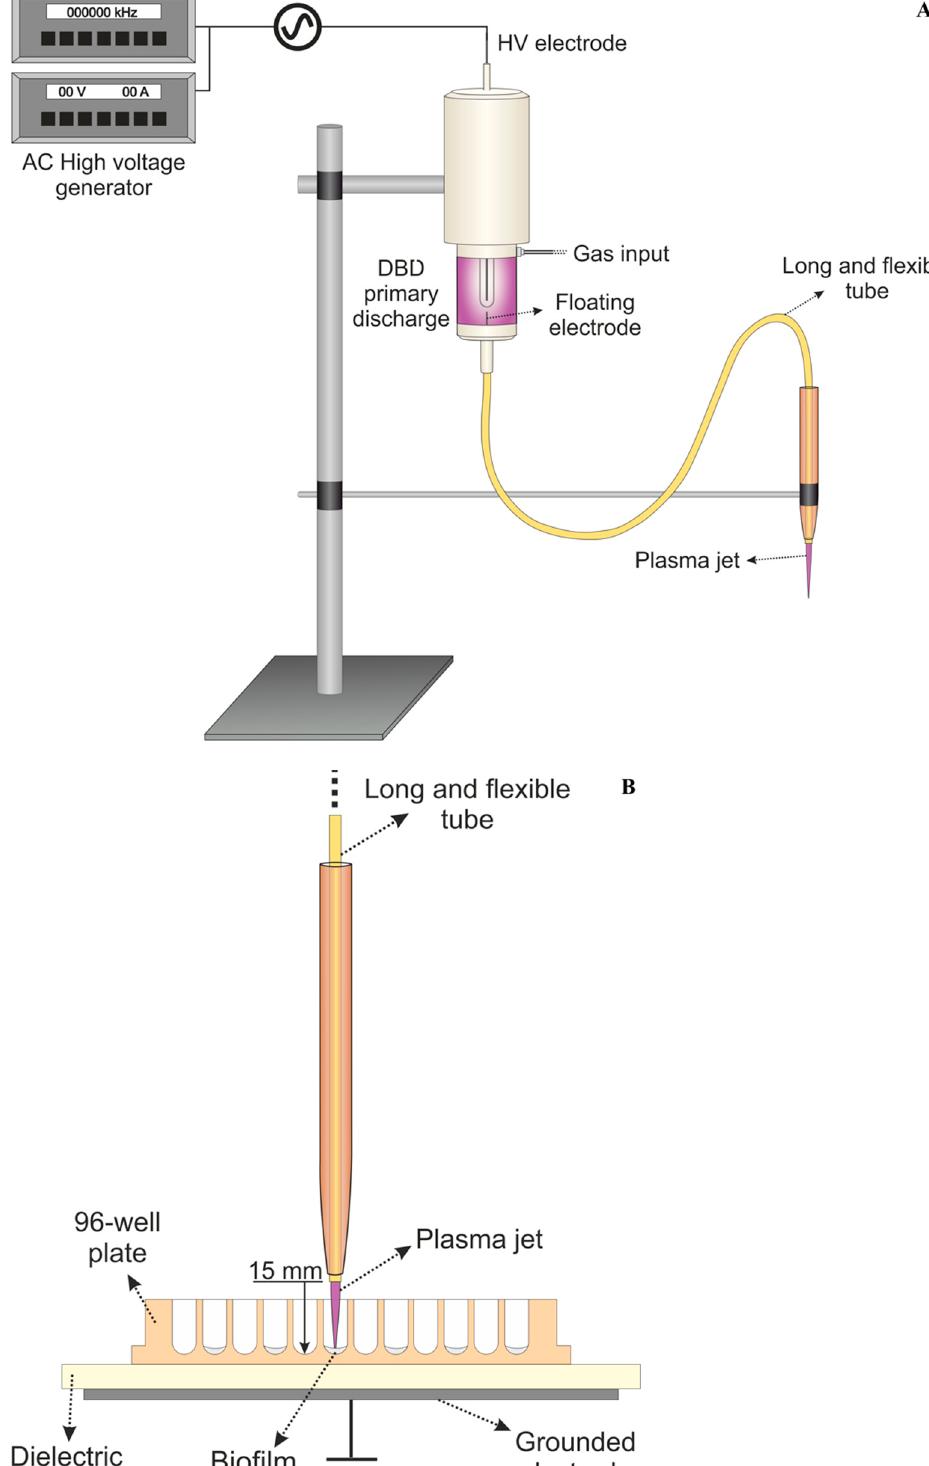
Figure 1. ( A ) Schematic setup of the plasma jet with flexible plastic long tube. ( B ) Scheme of plasma application in a 96-well plate during the experiments. application in a 96-well plate during the